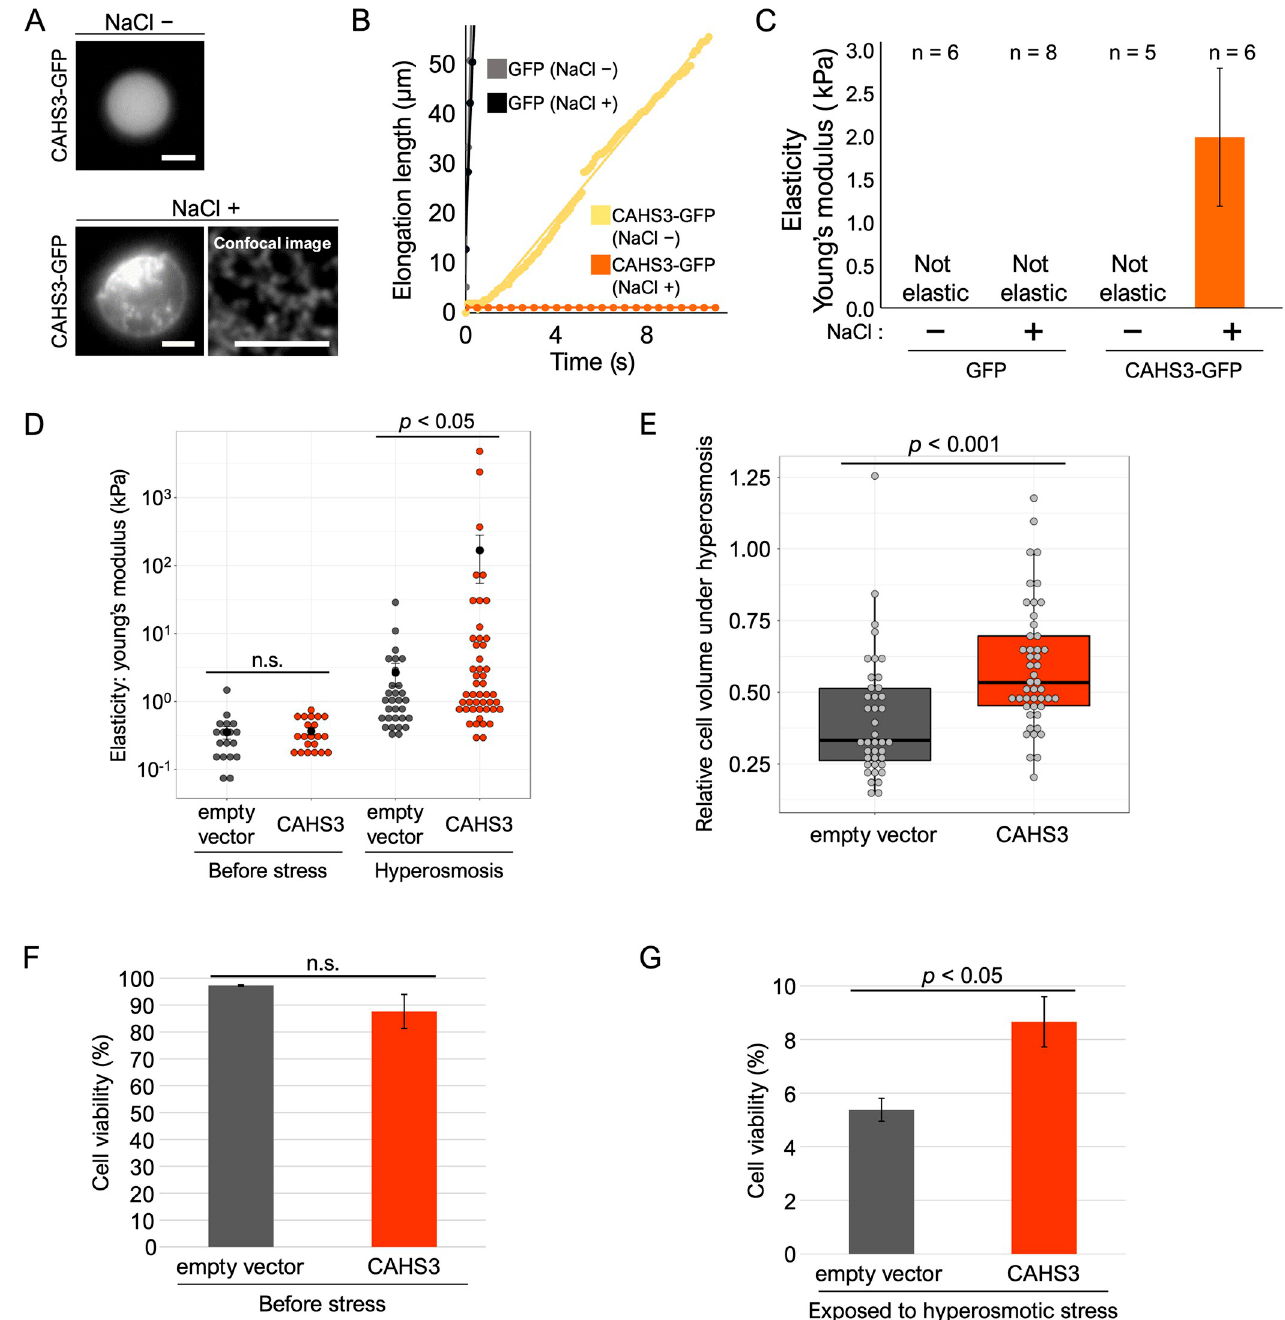
Fig 4. CAHS confers the mechanical resistance against deformation forces on cell-like microdroplets and insect cells. (A) Representative fluorescent images of a microdroplet containing CAHS3-GFP in the absence or presence of additional NaCl. Scale bar, 5 μ m. (B) Representative response curves of the elongation length of microdroplets containing CAHS3-GFP or GFP alone under a very small pressure ( << 0.5 kPa). Continuous elongation exceeding 50 μ m indicates not elastic and in a liquid phase. (C) Comparison of the elasticity (Young’s modulus) among droplets containing CAHS3-GFP or GFP with or without NaCl addition. Data are presented as average ± SE. (D) The effects of CAHS3-expression on the cortical elasticity of Drosophila S2 cells under hyperosmosis. CAHS3-stably expressing cells exhibited higher elasticity compared to the control cells transfected with empty vector under a hyperosmotic condition supplemented with 0.4 M trehalose for 3 h. Gray and red dots indicate the values of each measurement. Black dots and bars indicate averages and standard errors, respectively. (E) Comparison of cell volume changes by hyperosmotic stress between CAHS3-expressing cells and control cells. The relative cell volume was calculated by dividing the volume under hyperosmotic stress by the averaged cell volume under isosmotic conditions. Center bar and edges indicate 50th, 25th, and 75th percentiles, respectively, and whiskers correspond to the 1.5 interquartile range. (F and G) Comparison of cell viability between